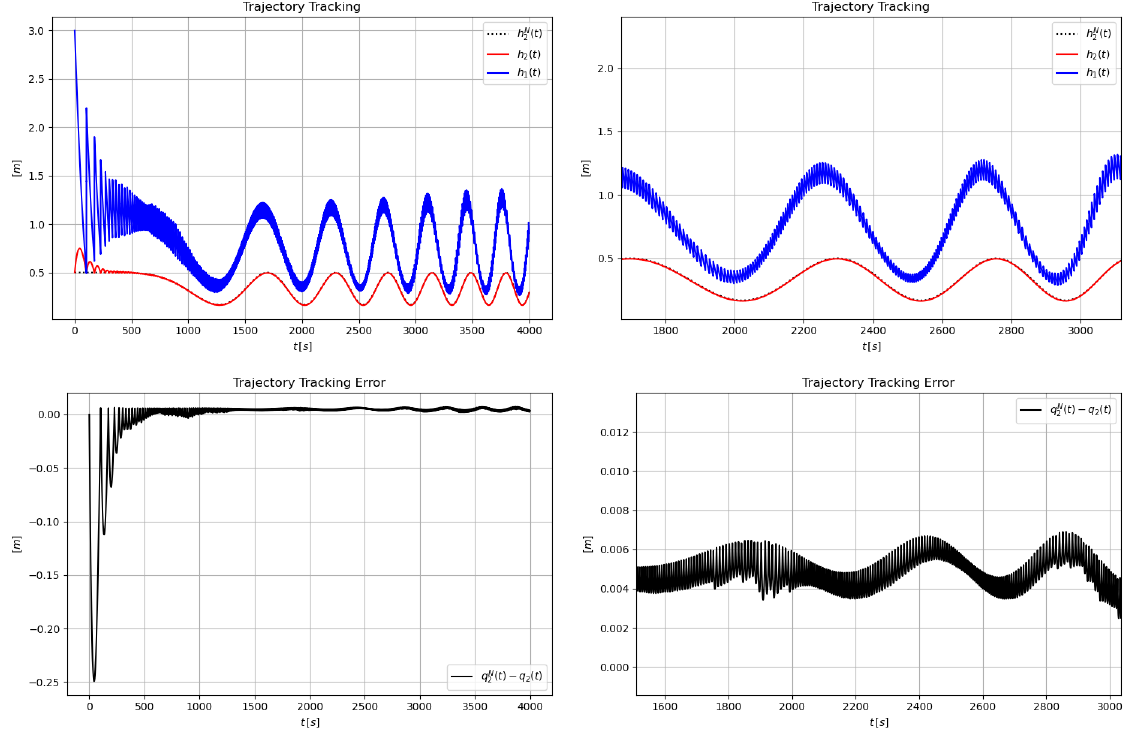
Figure 3. For Λ max = 5.5 with adaptivity: Trajectory tracking with its zoomed in excerpt (upper Left & Right Sides) and tracking errors with its zoomed in excerpt (bottom Left & Right Sides).